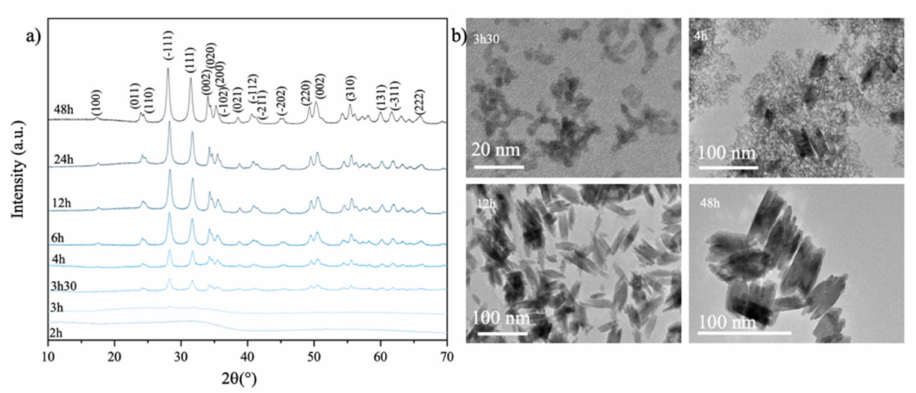
Figure 8. ( a ) Powder X-ray diffraction pattern of HfO 2-NPs synthesized at 180 ◦ C and pH 9.5 for 2–48 h. ( b ) Transmission electron bright field micrographs of the nanoparticles after 3.5, 4, 12 and 48 h of hydrothermal growth.